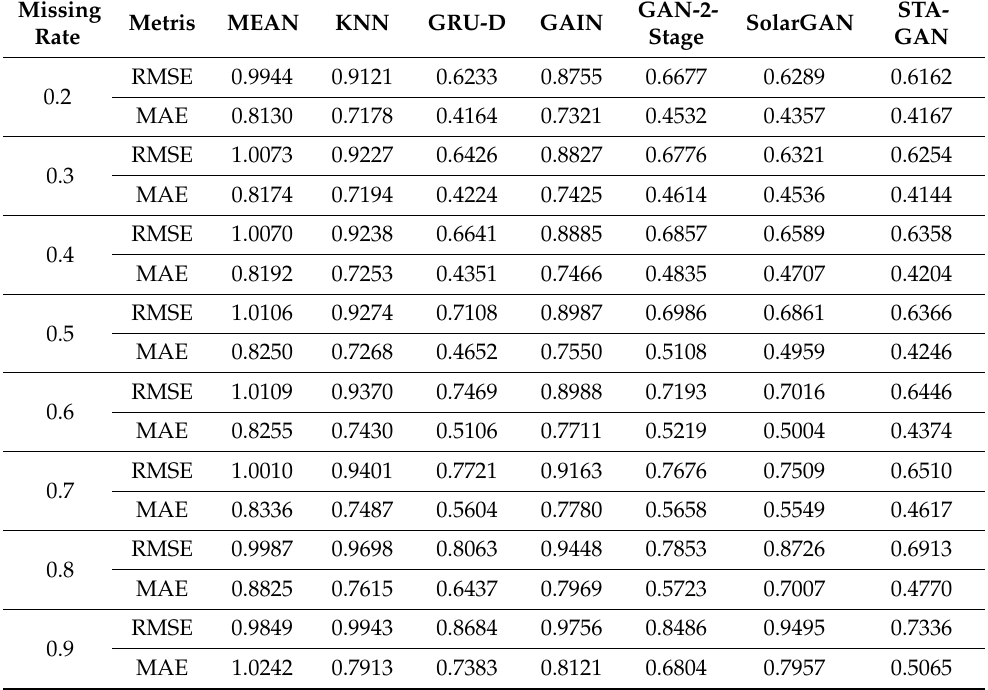
Table 3. The results (RMSE and MAE) of CHA-EAST dataset with different missing rates. Missing